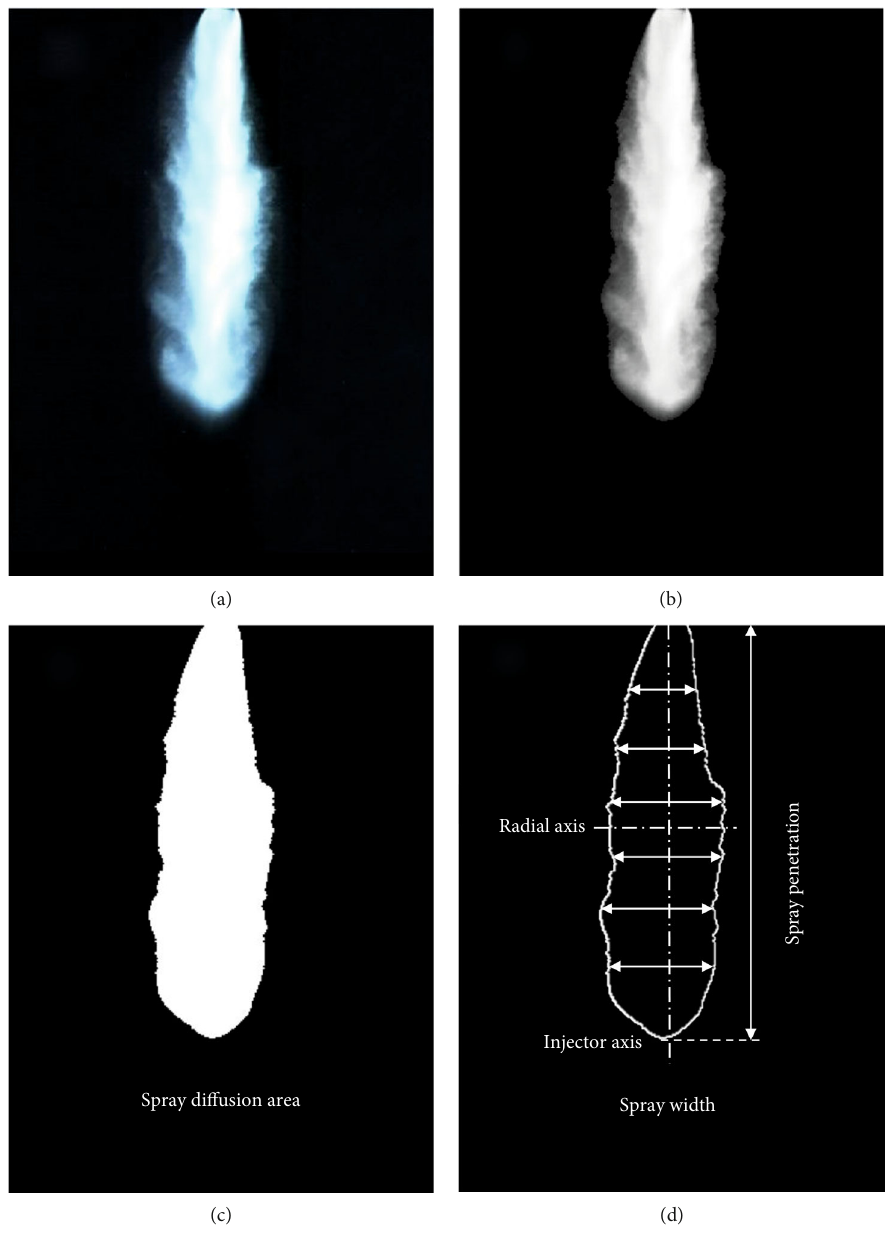
Figure 6: Spray image processing procedure and de fi nitions of spray di ff usion area, spray penetration, and spray